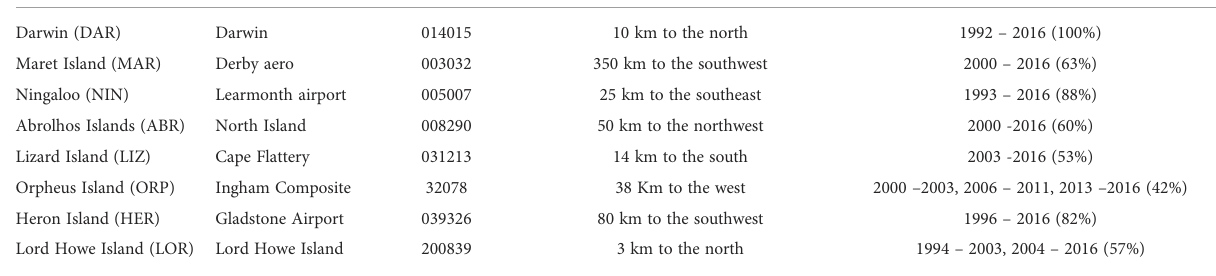
TABLE 2 Details of Bureau of Meteorology (BOM) stations and availability of wet-bulb temperature data used in analyses (for details see Supplementary Material 1